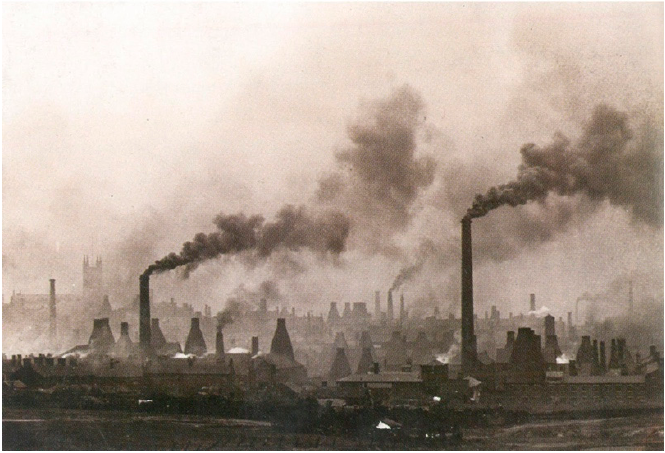
Figure 9. A postcard of bottle kilns in Longton, Stoke-on-Trent early 20th Century.